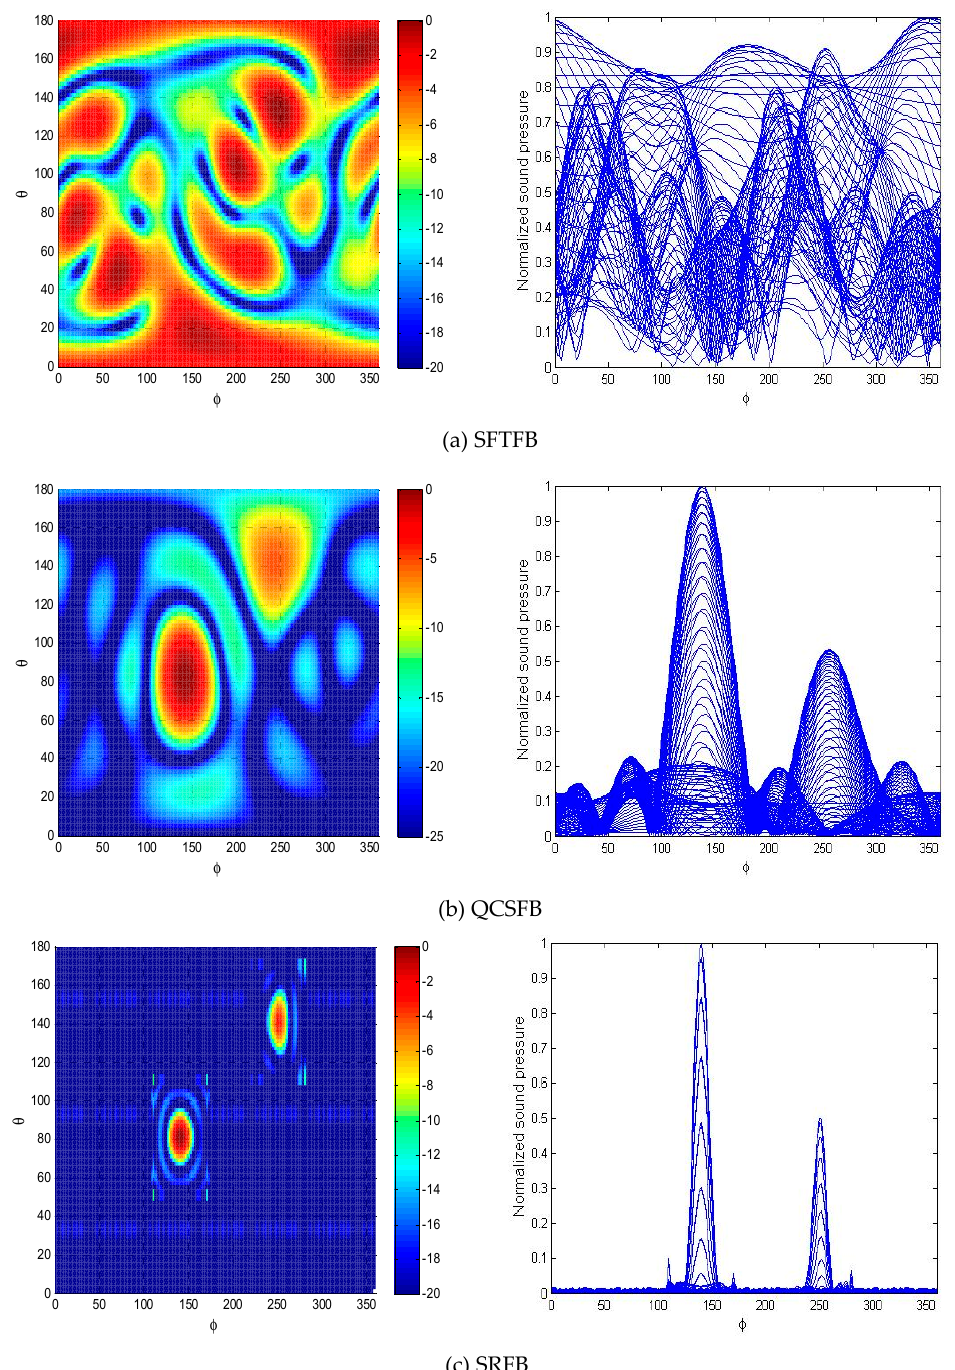
Figure 4. Spatial spectrum slices of two sound sources with unequal intensities obtained using the ( a ) SFTFB, ( b ) QCSFB and ( c ) SRFB methods.